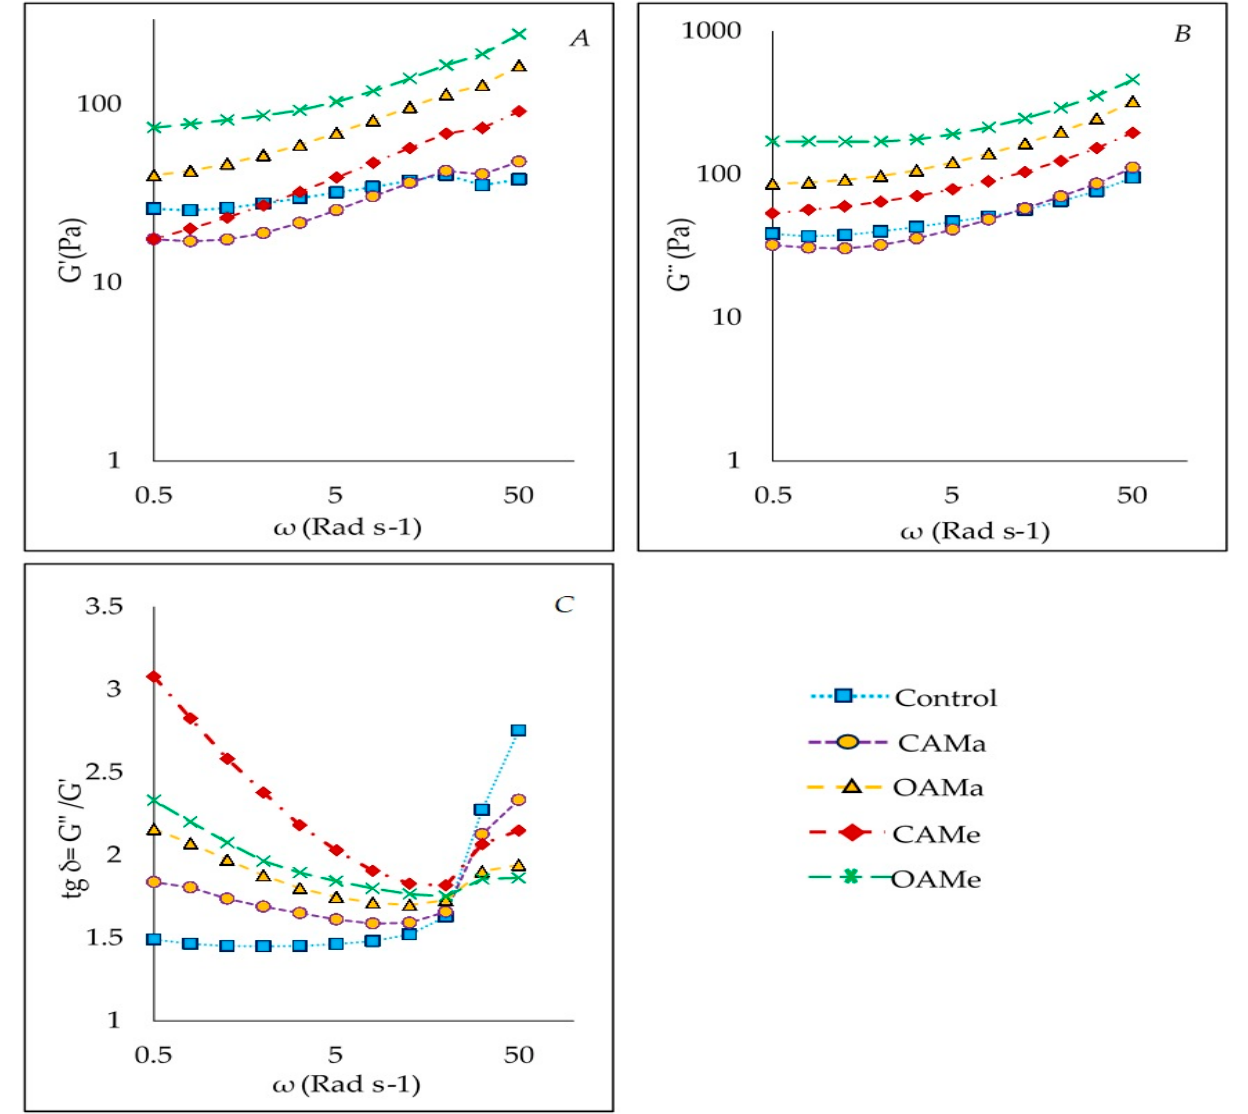
Figure 5. Rheological behavior of gluten-free muffins: ( A ) G (cid:48) , ( B ) G”, and (C) tg δ . All dough samples had a tan δ curve which tended to shift towards lower values (from 3 to 1.7). Therefore, tan δ values for all dough formulations were higher than 1, indicating that they were more liquid than solid-like materials. This behavior could be related to the ratio of the liquid phase used in the formulation which creates an emulsion type structure [69]. However, no information on doughs with these ingredients was available in the literature. The parameters for power-law equations for all samples are shown in Table 4. The rheological behavior indices, n (cid:48) and n” values were less than 1, which is indicative of the pseudoplastic nature of the doughs. While n” was almost double of that of n (cid:48) in the control, for CAMa it was similar. On the contrary, in OAMa, CaMe and OAMe the values of n” were less than those of n (cid:48) . Regarding the observed consistency values for the storage and loss equations, K” was always higher than K (cid:48) in all samples, but the K”/K (cid:48) ratio was very different among samples, being the lowest in the control. The values of K (cid:48) and K” increased when sweetener was used, which indicates that sucralose led to a slightly stronger Table 4. Rheological properties of dough of gluten-free muffins produced with ACF. Sample